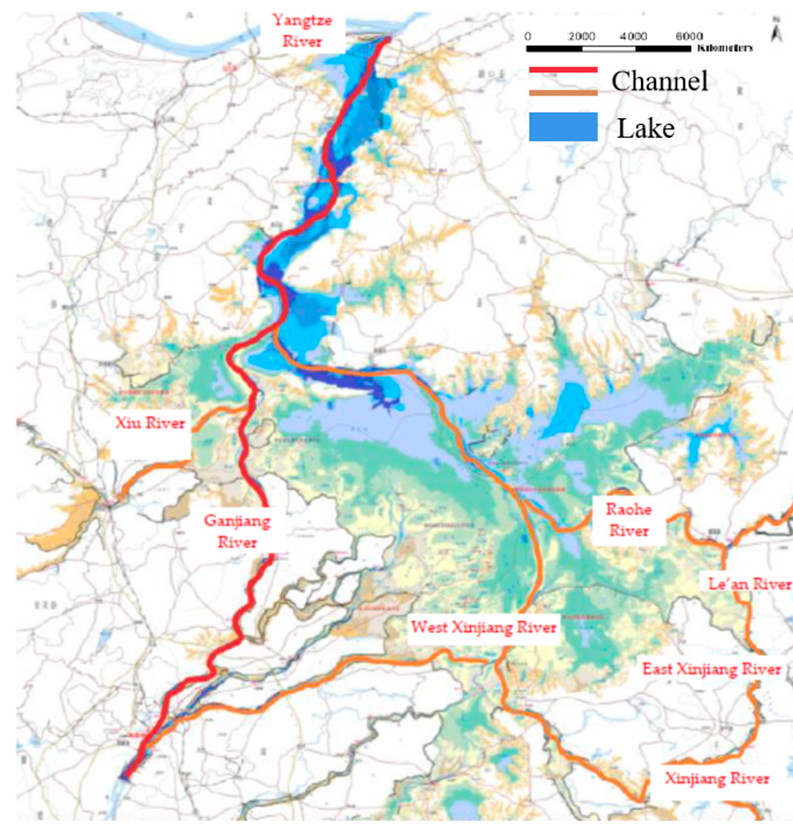
Figure 2. Schematic diagram of the main waterways in the Poyang Lake.